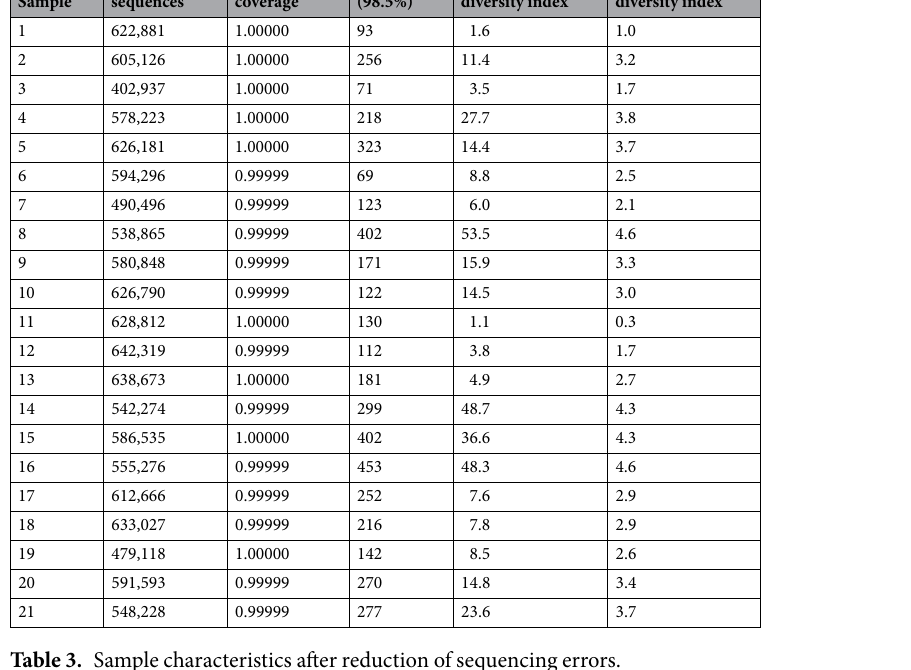
Table 3. Sample characteristics after reduction of sequencing